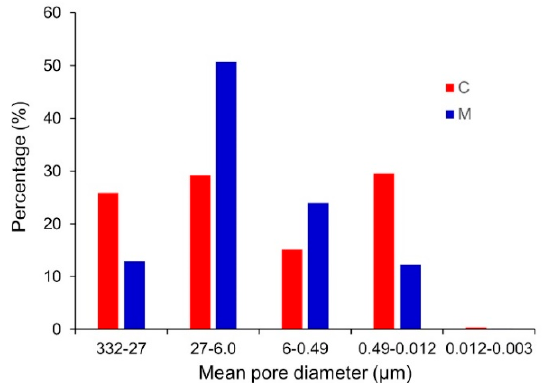
Figure 2. Pore-size distributions for the lithotypes C and M, measured by the mercury intrusion porosimetry method.